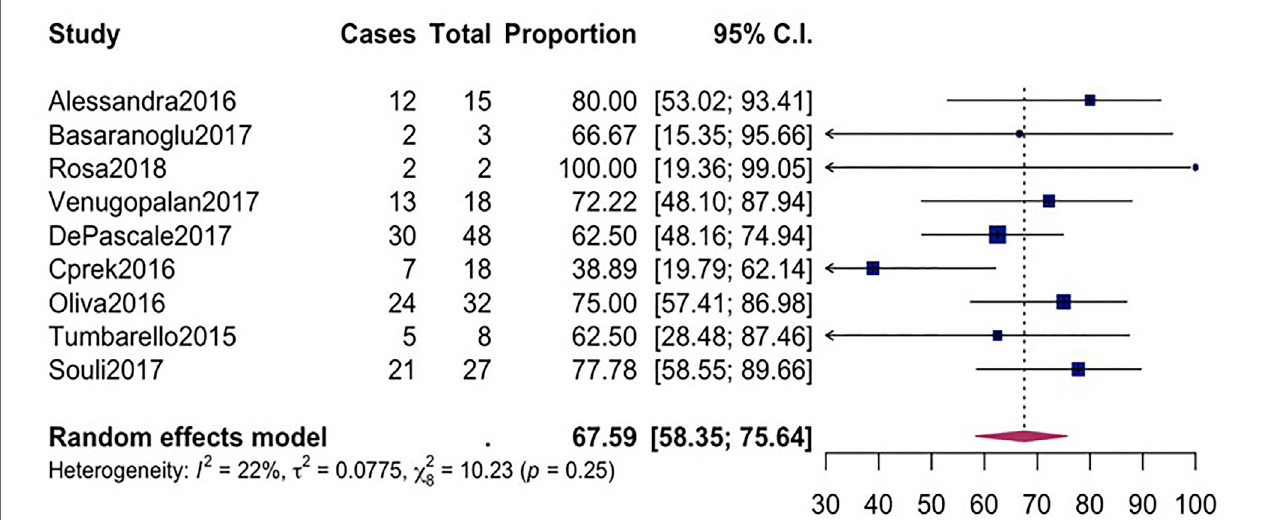
FIGURE 3 | Forest plot for pooled clinical success among CpKP infected patients after antibiotic regimes.